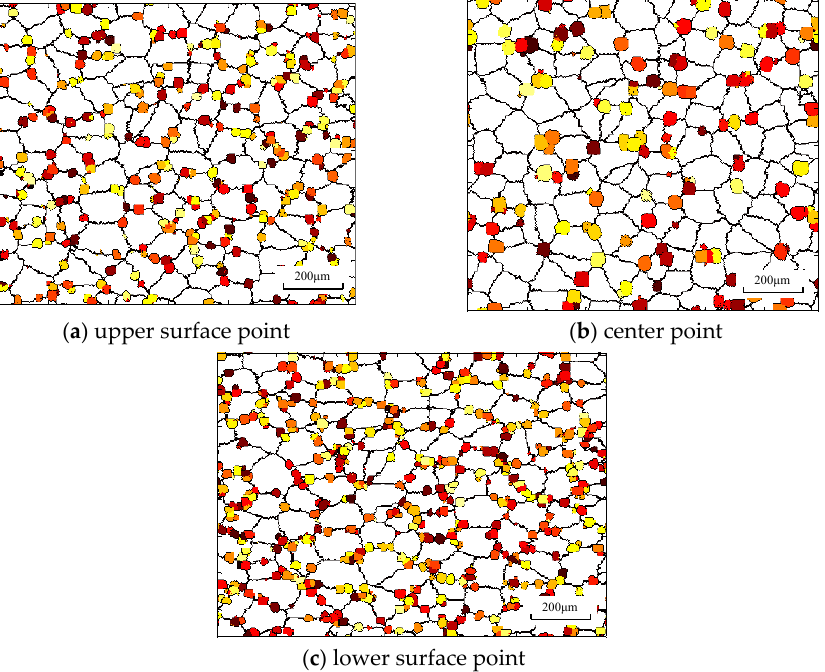
Figure 9. Microstructure under conditions i = 1.1 and S = 40 mm during the cross shear zone.